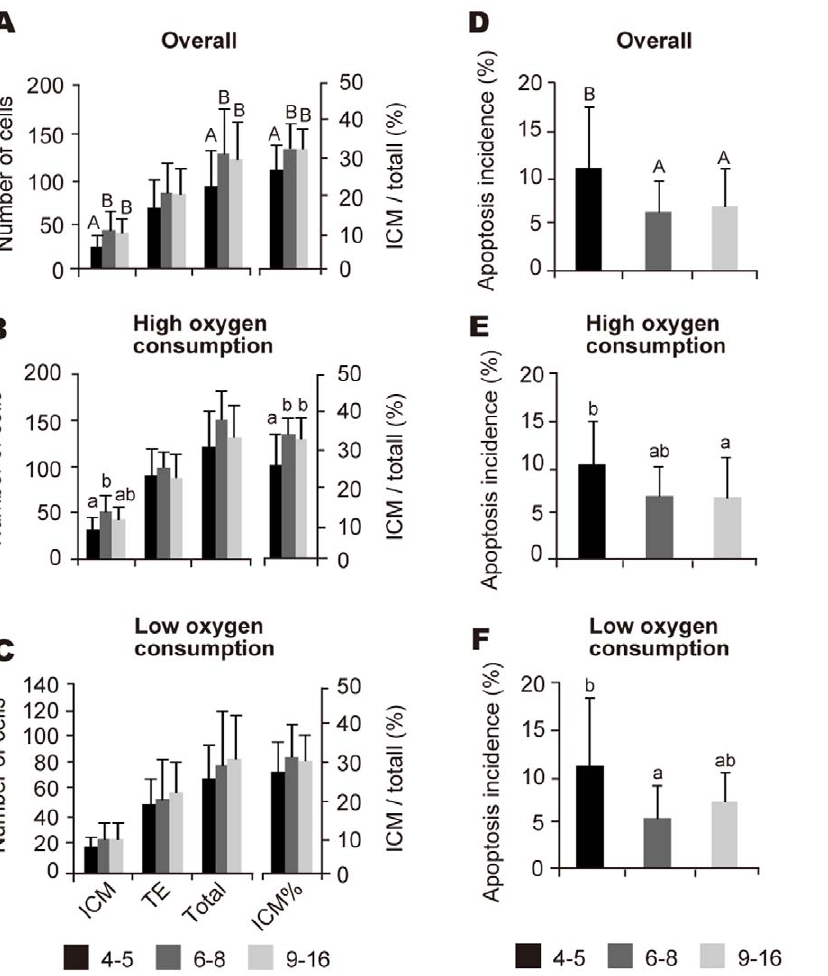
Figure 3. The effect of the number of blastomeres at the onset of the lag-phase on cell numbers, ICM ratio, and apoptosis incidence. The number of total, ICM, and TE cells, the ICM ratio, and the apoptotic incidence in blastocysts with different numbers of blastomeres at the onset of the lag-phase are shown in A and D , respectively. Embryos were separated into groups based on high ( B and E ) or low oxygen consumption ( C and D ) with a cut-off of 0.84 6 10 2 14 mol s 2 1 . Data are presented as the mean 6 SD. Different letters indicate significant differences between groups based on one-way ANOVA followed by Fisher’s protected least signicicant difference (PLSD) ( A,B P , 0.01; a,b P , 0.05). doi:10.1371/journal.pone.0036627.g003 with 3/4 blastomeres at the end of the first cleavage (Fig. 4D) or with 4/5 blastomeres at the onset of the lag-phase (Fig. 4F) also had a higher rate of mixoploidy. Moreover, blastocysts derived from embryos with 3/4 blastomeres at the end of the first cleavage had higher incidences of abnormal chromosomes per blastocyst as compared with those with 2 blastomeres (Fig. 4G). Overall, diploid blastocysts were observed with a frequency of 56.8% (63/111). Most (77.8%; 49/63) blastocysts were derived from rapidly cleaving embryos with2blastomeres atthe endofthe first cleavage andeither 6–8 or 9–16 blastomeres at the onset of the lag-phase. These blastocysts had a high possibility of diploidy (Fig. 4K) and a low incidence of abnormal chromosomes per blastocyst (Fig. 4L). We observed that accumulation of abnormal phenotypes at the first cleavage and at the onset of the lag-phase appeared to have an increasingly serious influence on chromosomal complementation (Fig. 4F and G).